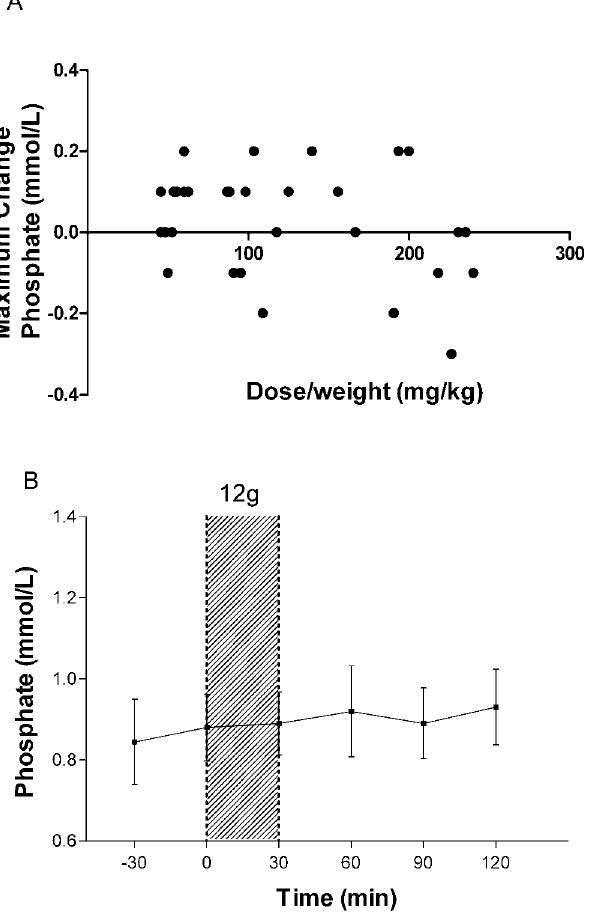
Figure 7. Effects of L-arginine hydrochloride infusion on plasma phosphate concentrations. Figure 7A: Relationship between dose/weight (mg/kg) of infused L-arginine and the maximal decrease in plasma phosphate concentration at any time during or in the two hours following infusion (n=30; r= 2 0.06, p=0.8). Figure 7B: Plasma phosphate concentrations of patients before and after 30 minute administration of the highest dose of L-arginine (12 g; n=10).. Shaded area indicates time of L-arginine infusion. Dots and bars indicate mean 6 SEM.